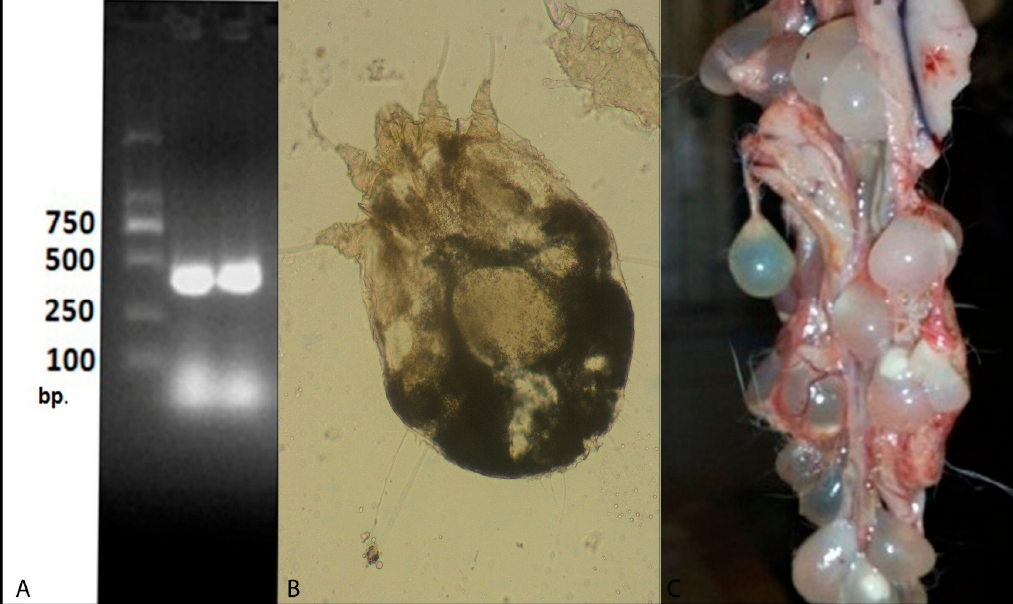
Figure 2. ( A ) Cysticercus pisiformis from the peritoneal cavity of rabbits, ( B ) Sarcoptes scabiei from the rabbit skin, and ( C ) analysis of Salmonella pure culture with the primer set: ST11-ST15. Lane 1 and Lane 2: